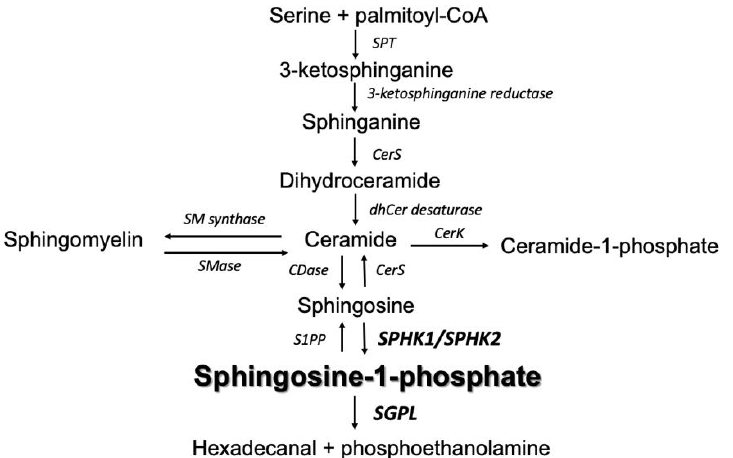
Figure 1. Overview of sphingolipid metabolism. SPT serine palmitoyltransferase. CerS ceramide synthase. CerK ceramide kinase. dhCer desaturase dihydroceramide desaturase. CDase cerami- dase. SMase sphingomyelinase. SM synthase sphingomyelinase synthase. S1PP sphingosine-1-phosphate phosphatase. SPHK1/SPHK2 sphingosine kinase 1 and 2, respectively. SGPL sphingosine 1-phosphate lyase.